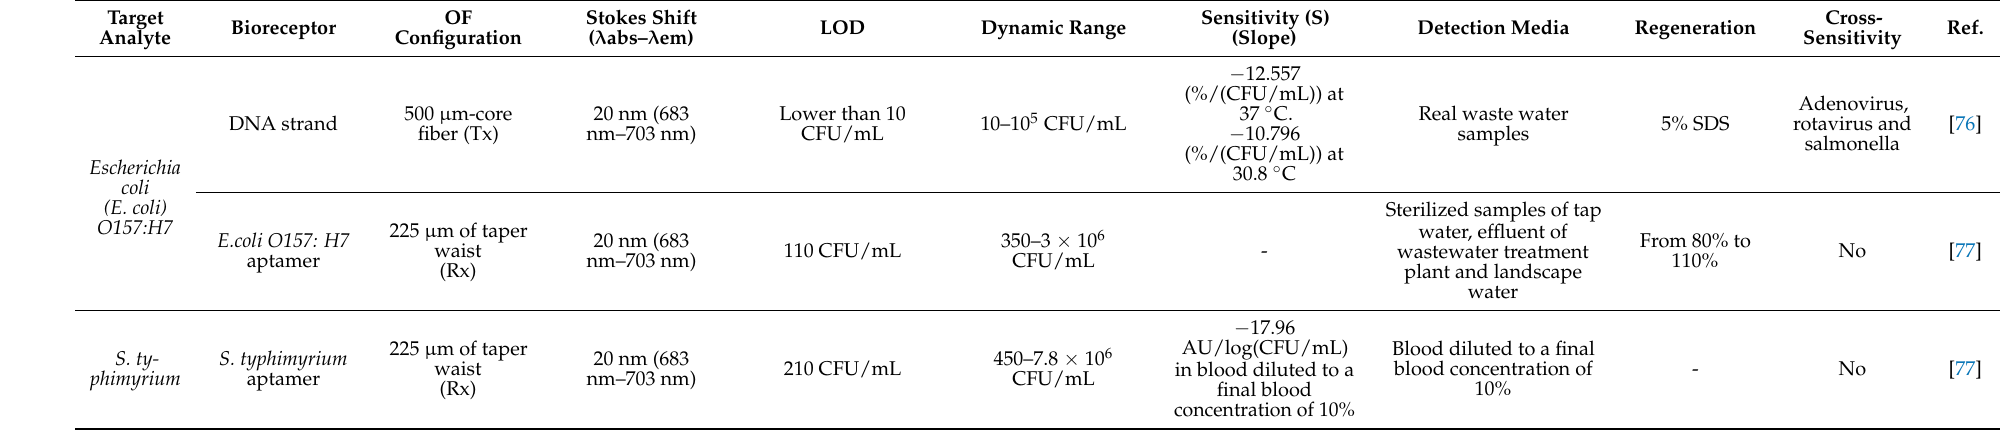
Table 2. Optical fiber biosensors based on luminescence using DNA strands or aptamers as bioreceptors for the detection of analytes different from DNA strands. The dash indicates that information about that parameter is not available in the original